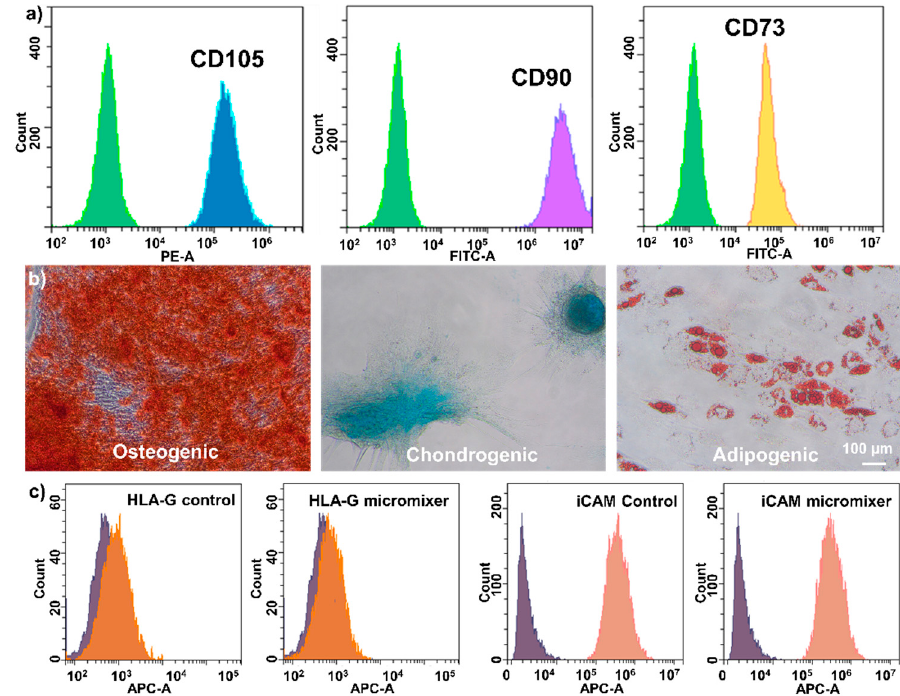
Figure 5. Characterisation of stem cell properties after thawing. ( a ) The micromixer-cryopreserved cells preserved their MSC identities, expressing all three MSC surface markers. ( b ) The osteogenic, chondrogenic, and adipogenic cells showed that the micromixer-cryopreserved cells also maintained the differentiation potentials. ( c ) Comparison of the expression levels of the surface therapeutic markers in the control and microfluidic groups, showing the therapeutic properties of the MSCs passed through the micromixer were not hampered.